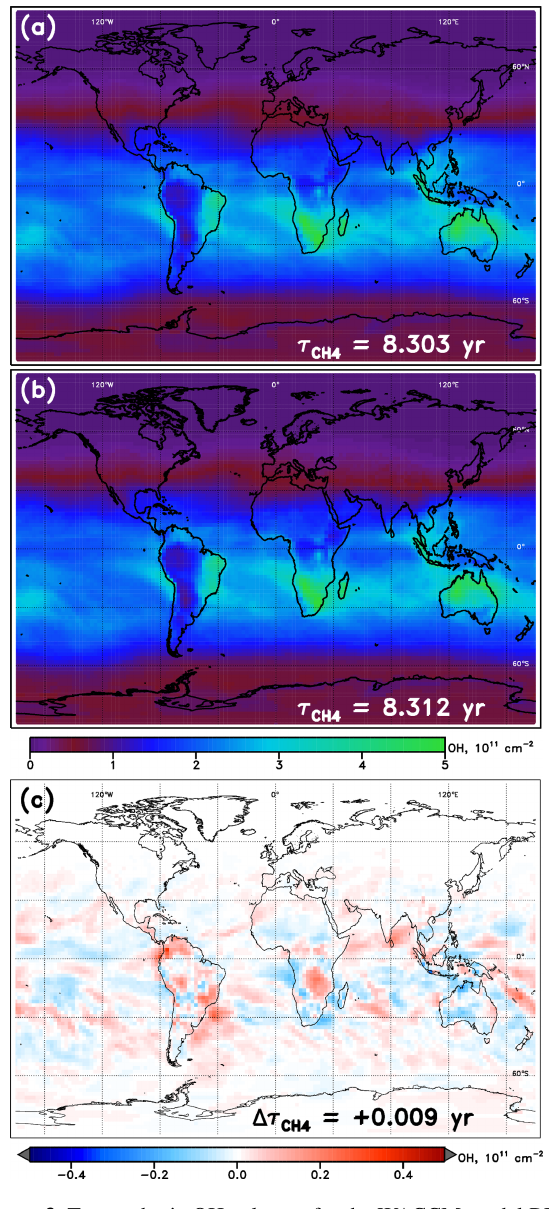
Figure 3. Tropospheric OH columns for the WACCM model REF- C1SD simulation, January 2000. (a) Columns calculated directly from the WACCM output; (b) columns calculated from the out- put from the WACCM January NN run with inputs from the native model; (c) difference in column values (NN – model). Methane life- time values calculated from 3-D OH fields from WACCM and from the WACCM NN are inscribed in panels (a) and (b) , respectively. The methane lifetime difference (NN – model) is noted in panel (c) .